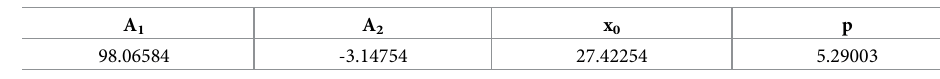
Table 24. Fitting equation parameters of accessibility of 16–44.